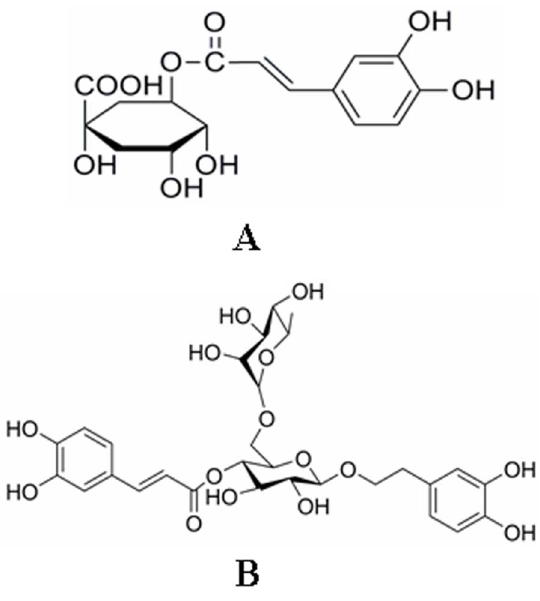
Figure 1. Chemical structure of FTA and CHA (A: CHA; B: FTA).